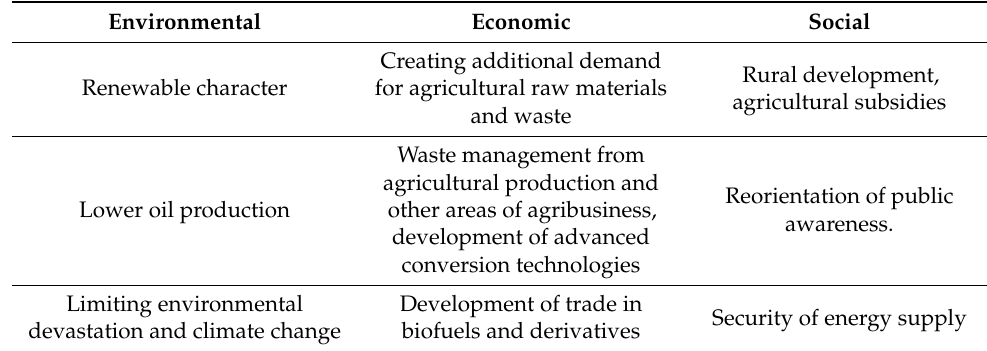
Table 2. Advantages of biofuels contributing to environmental, economic and social order [24,25]. Environmental Economic Social Creating additional demand Rural development, Renewable character for agricultural raw materials agricultural subsidies and waste Waste management from agricultural production and Reorientation of public Lower oil production other areas of agribusiness, awareness. development of advanced conversion technologies Limiting environmental Development of trade in Security of energy devastation and climate change biofuels and derivatives